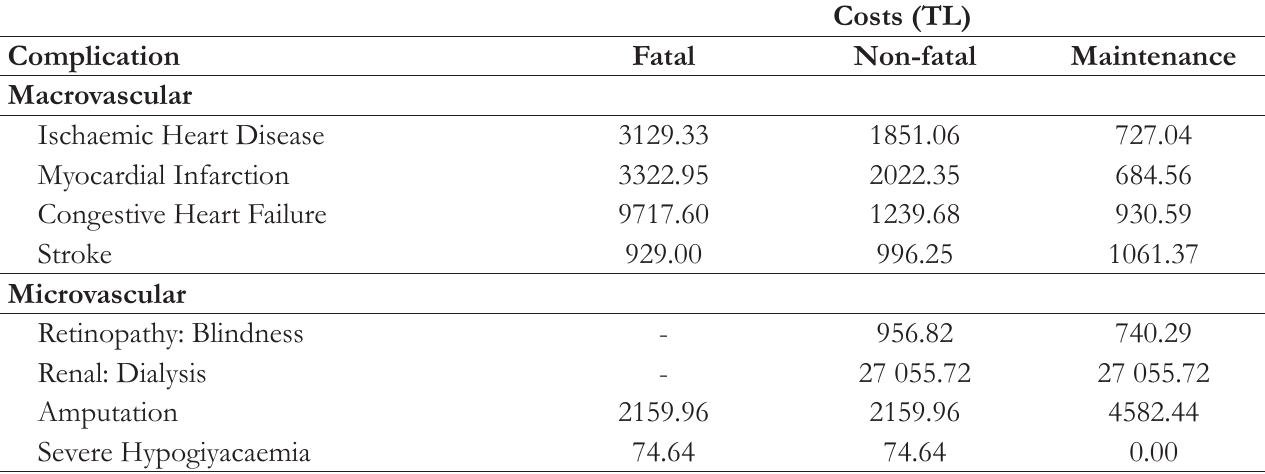
Table 4. Fatal and Non-fatal Event and Maintenance Costs Applied in the T2DM Model